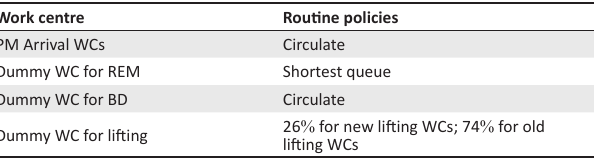
TABLE 7: Routine policies for work centres.